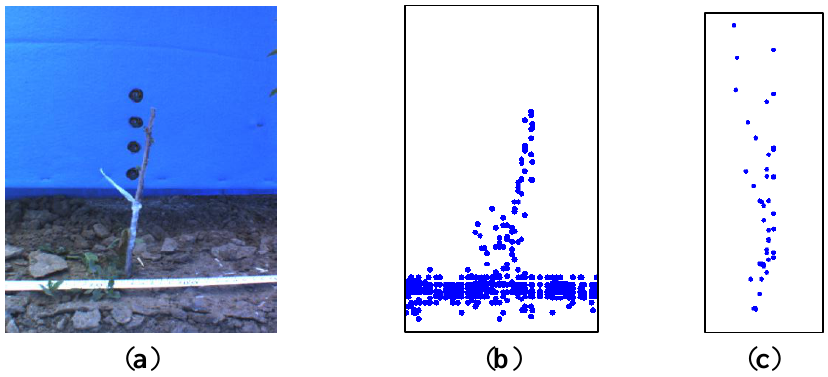
Figure 3. A sample of the LIDAR outlier that occurs at the boundary of an occlusion. ( a ) Image of the scanned tree. ( b ) Front view of the detection recorded of the tree by the LIDAR sensor. ( c ) Top view of the detection recorded of the tree by the LIDAR after ground